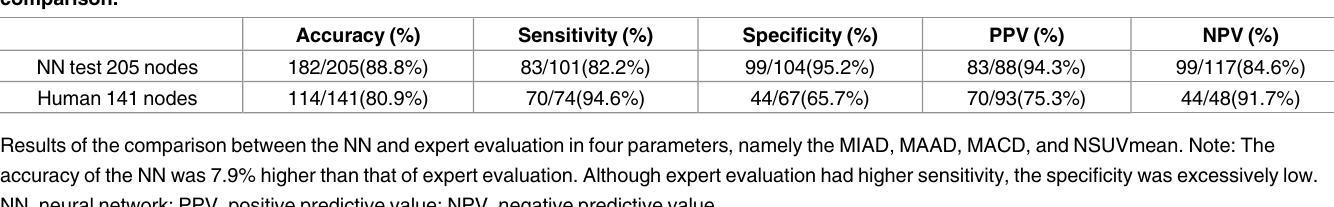
Table 2. Accuracy, sensitivity, specificity, and positive and negative predictive values of the NN and expert evaluation in the stage II comparison.